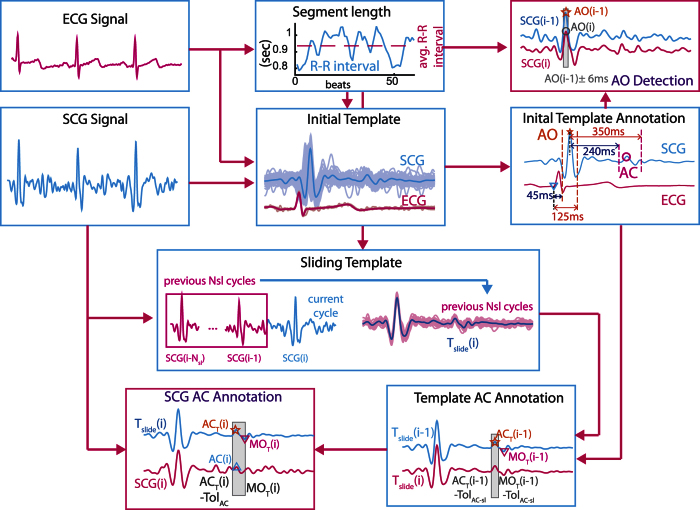
Proposed Approach.